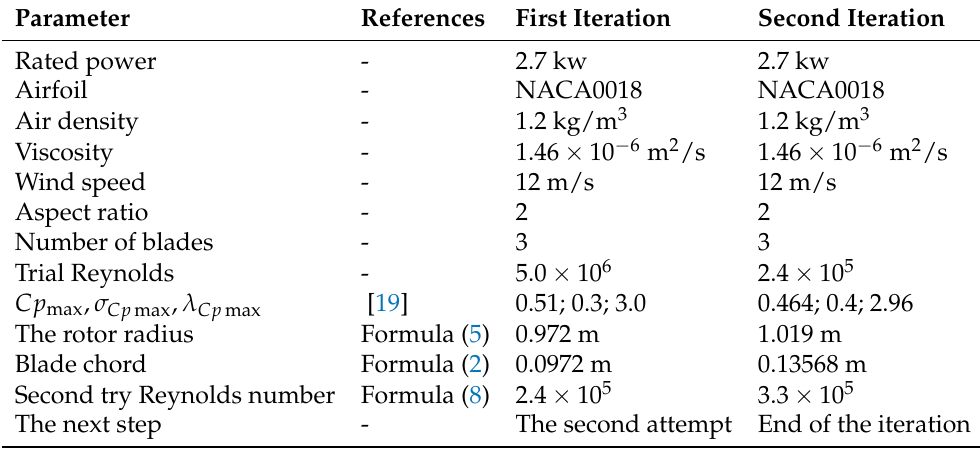
Table 1. Offshore wind turbine design iteration